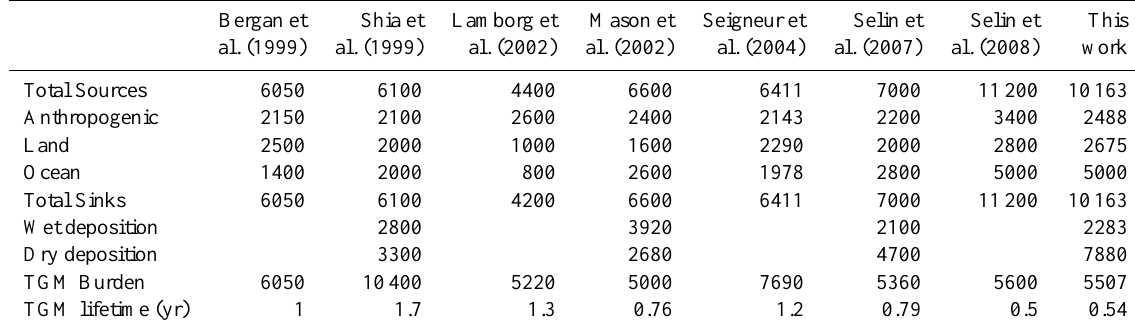
Table 2. Global budgets of TGM in the literature (in Mgyr − 1 ) . Bergan et Shia et Lamborg et Mason et